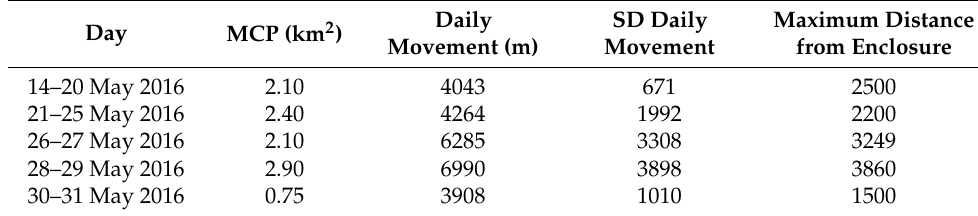
Table 1. European bison activity in the first weeks after release.